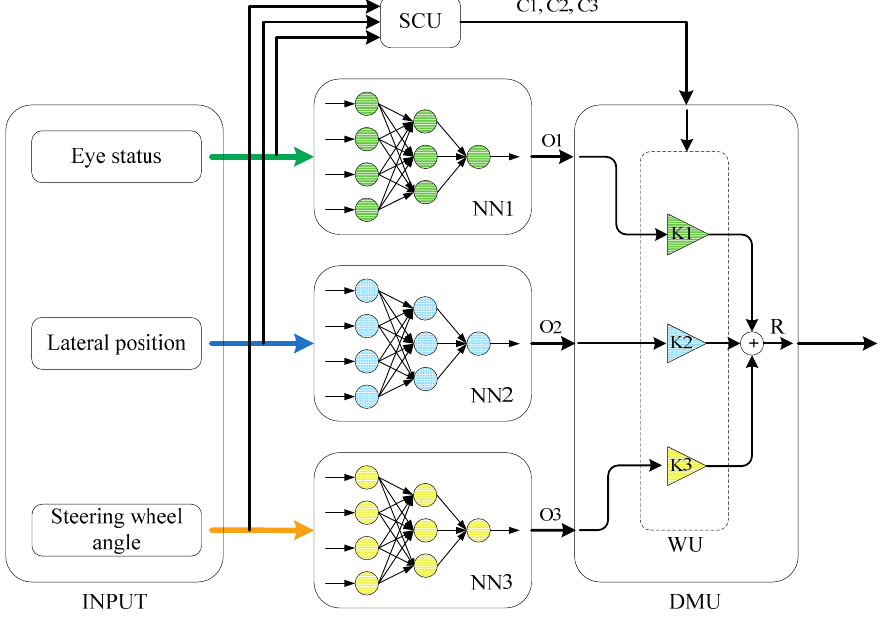
Figure 8. The structure of the proposed drowsiness detection